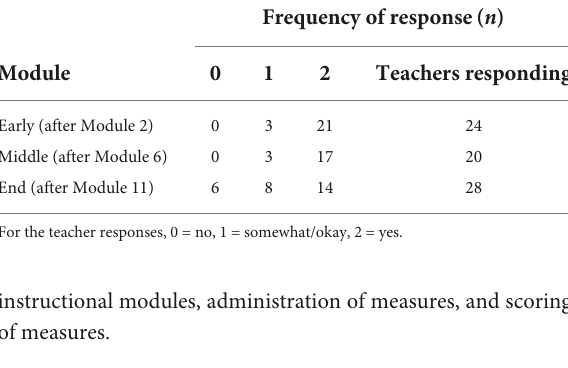
TABLE 8 Final questionnaire: Acceptability of time for professional development (PD), administration, and scoring.